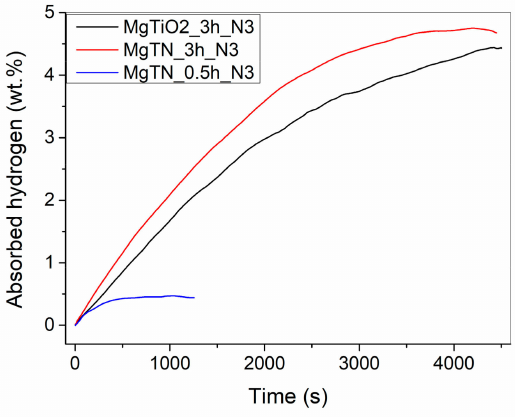
Figure 9. Absorption kinetic curves of the Mg-based composites processed by HPT for N = 3 rotations.